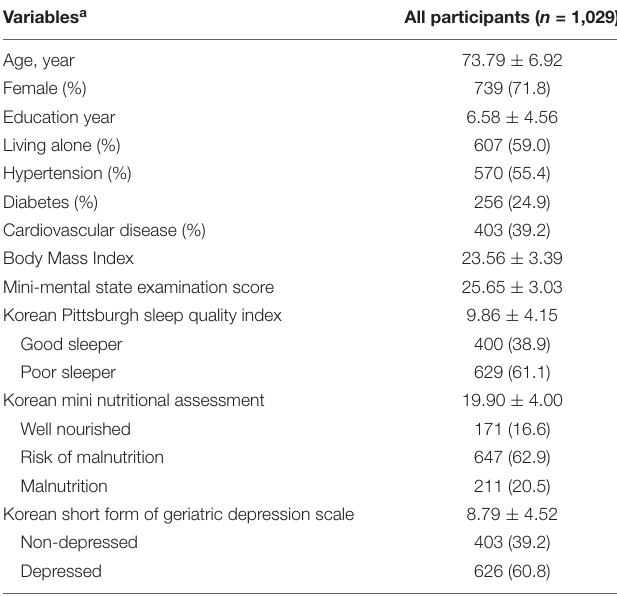
TABLE 1 | Demographic characteristics of the study